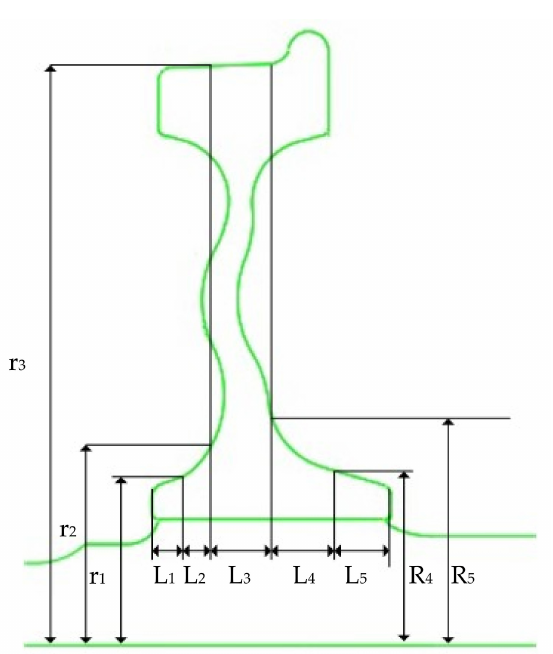
Figure 2. Simplified model of a wheelset for theoretical analysis